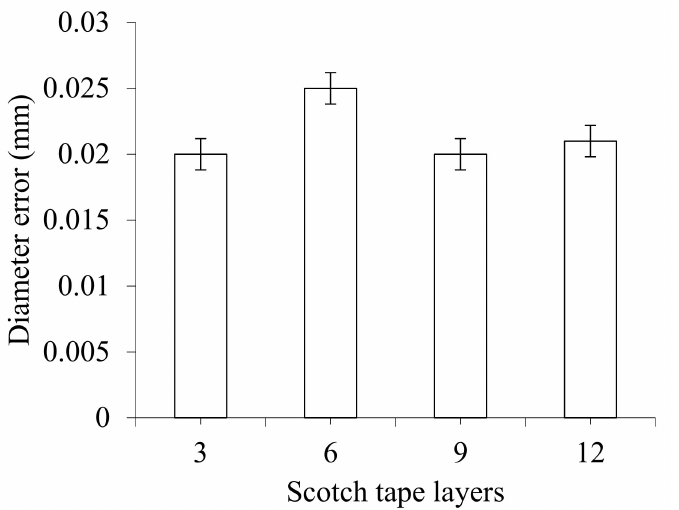
Figure 9. Effect of number of Scotch tape layer on diameter error at drill bit diameter of 6 mm, point angle of 125 ◦ , spindle speed of 2250 rpm, and feed rate of 0.11